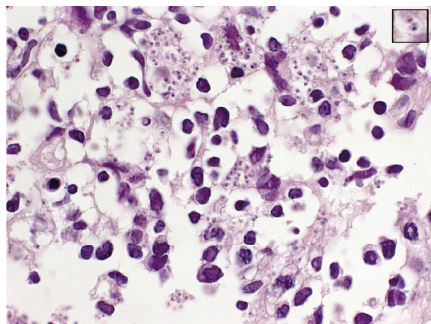
Figure 3: Transbronchial needle biopsy of a mediastinal lymph node showing histiocytes containing abundant Leishmania amastigotes (H-E × 1000). Insert shows a close-up view of an amastigote. Its ovoid shape, eccentric nucleus, and kinetoplast are